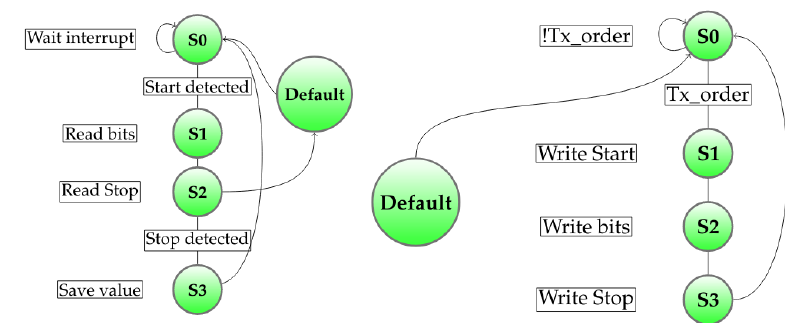
Figure 11. Rx ( left ) and Tx ( right ) automatons.